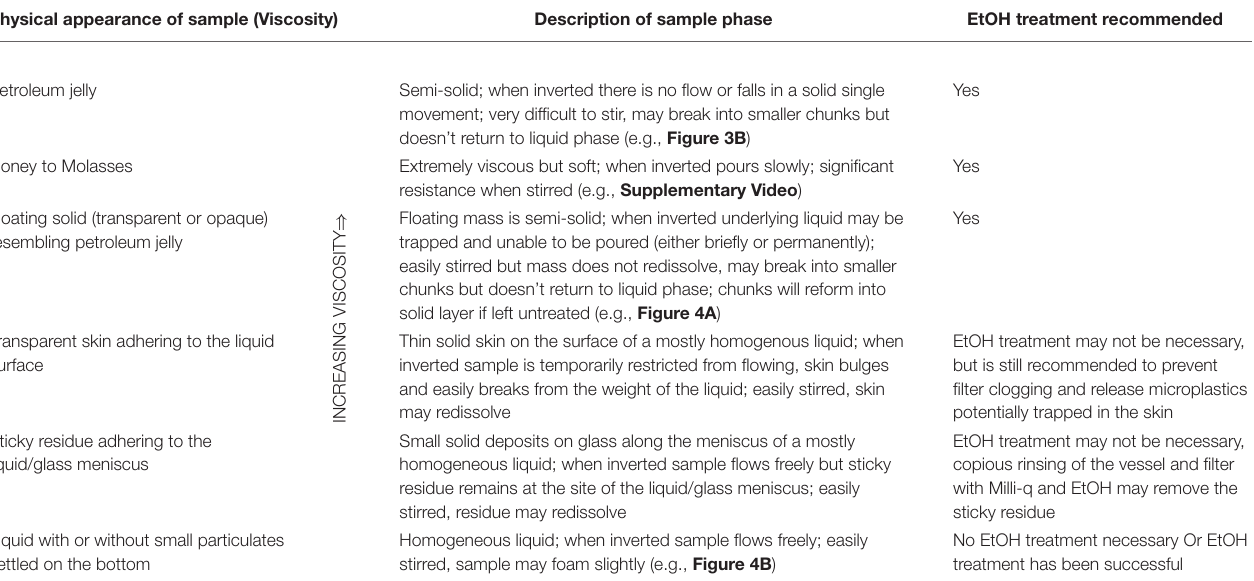
TABLE 2 | Saponification visual assessment